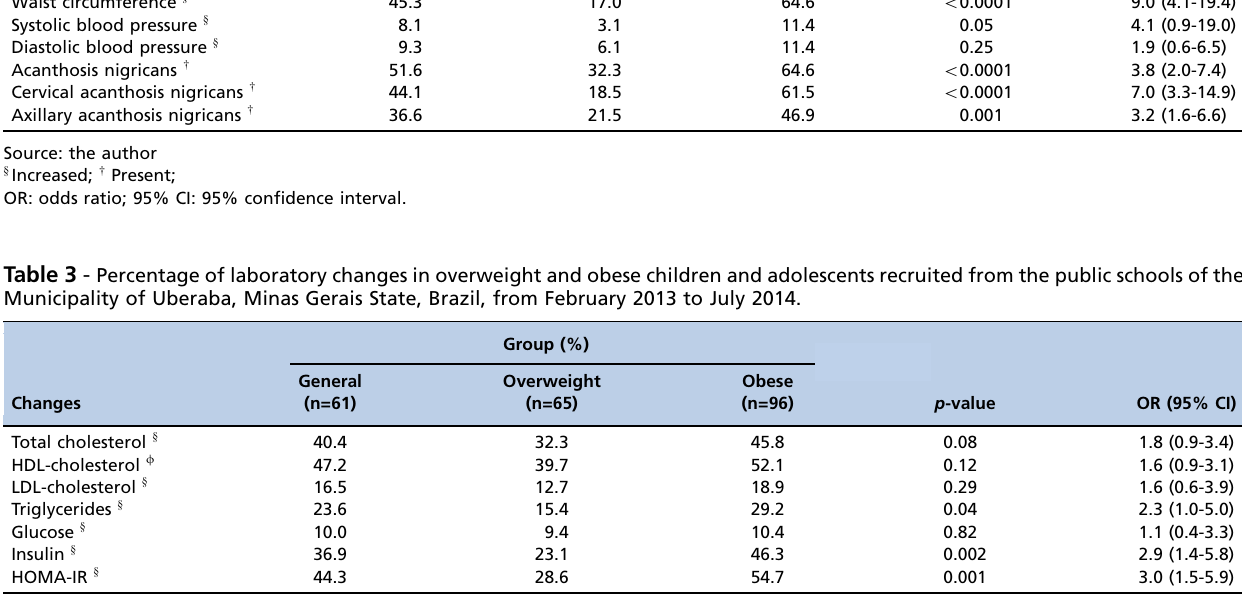
Table 2 - Percentage of clinical changes in overweight and obese children and adolescents recruited from the public schools of the Municipality of Uberaba, Minas Gerais State, Brazil, from February 2013 to July 2014. Group (%) General